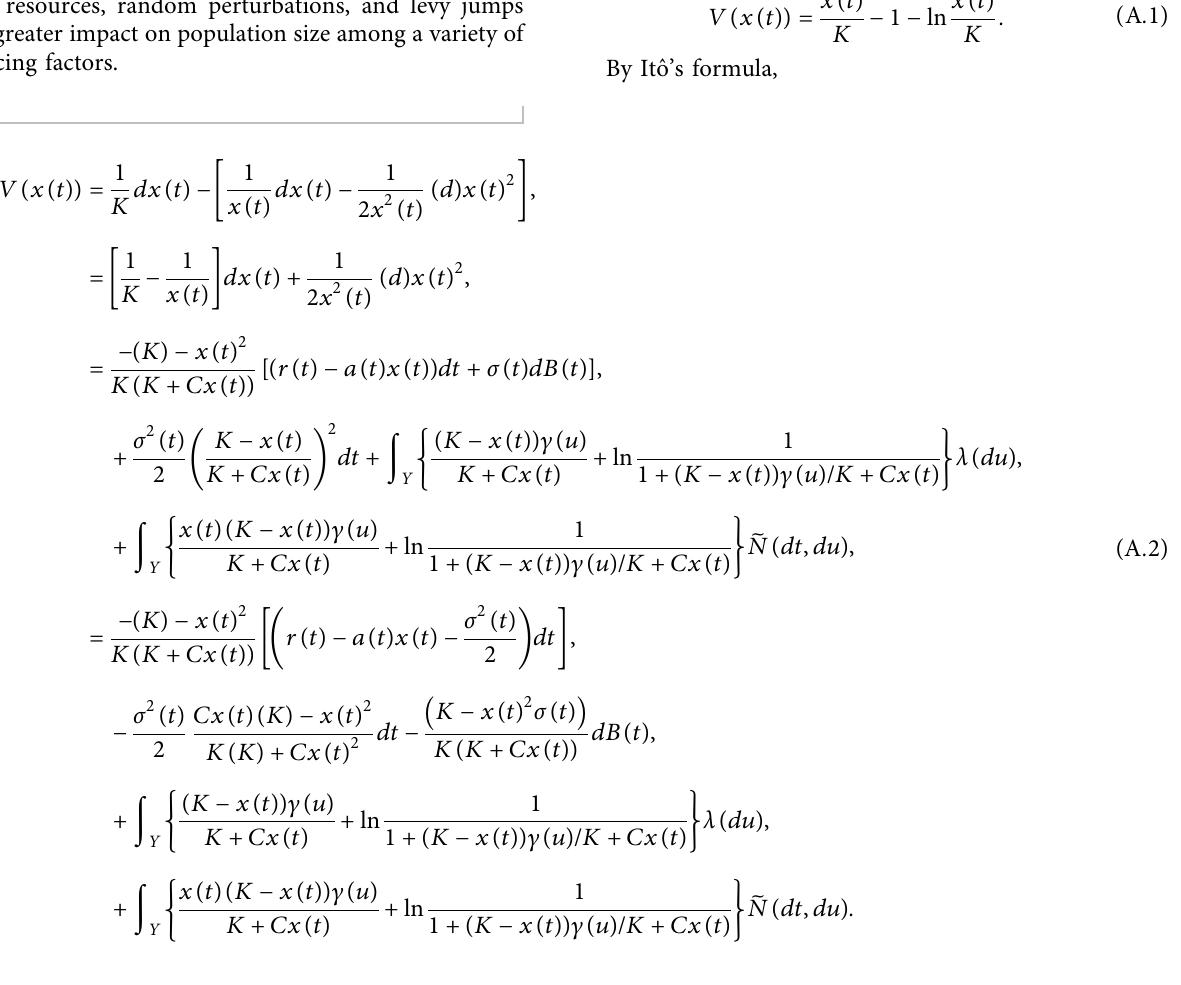
Figure 6: Te lines represent the solution of model (8) for r ( t ) � 0 . 4 + 0 . 5sin t, K � 1 ,C � 1 . 2, initial data x (a) a ( t ) � 0 . 1 , σ ( t ) � 0 , c ( u ) � − 0 . 3; (b) a ( t ) � 0 . 1 , σ ( t ) � 0 . 2 , c ( u ) � − 0 .